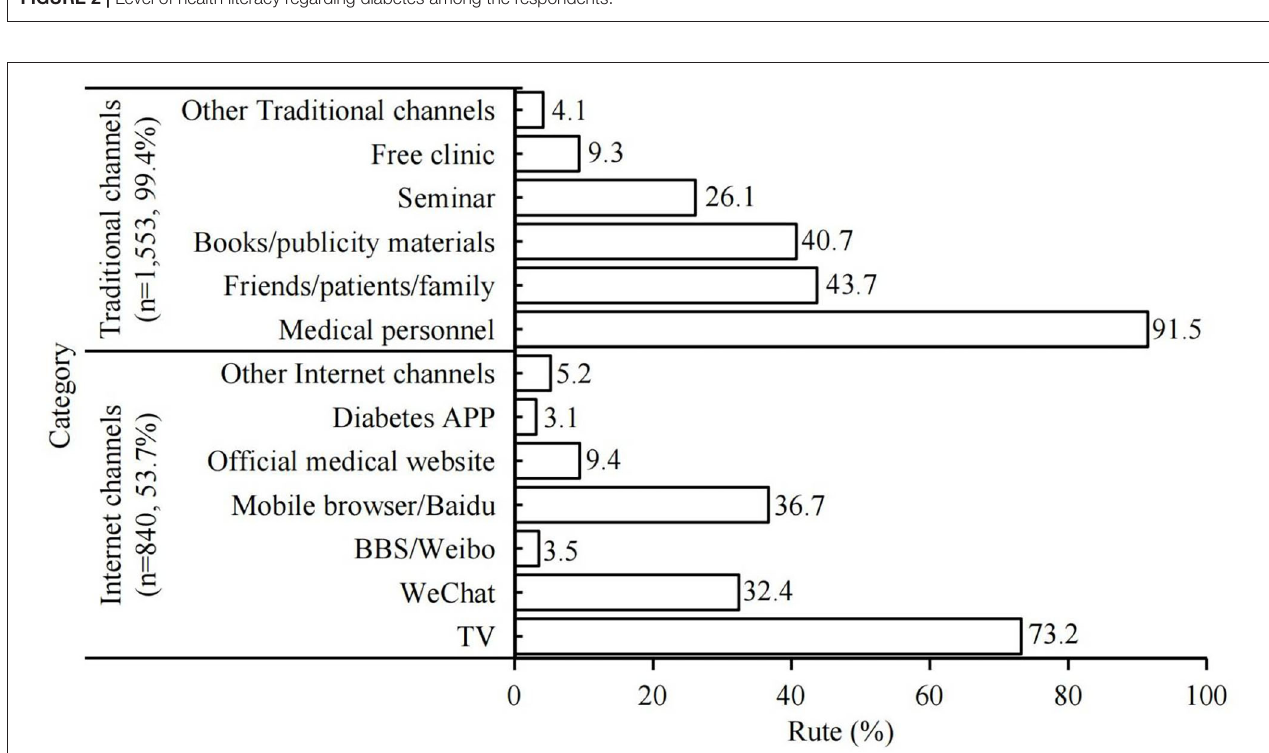
FIGURE 2 | Level of health literacy regarding diabetes among the respondents.